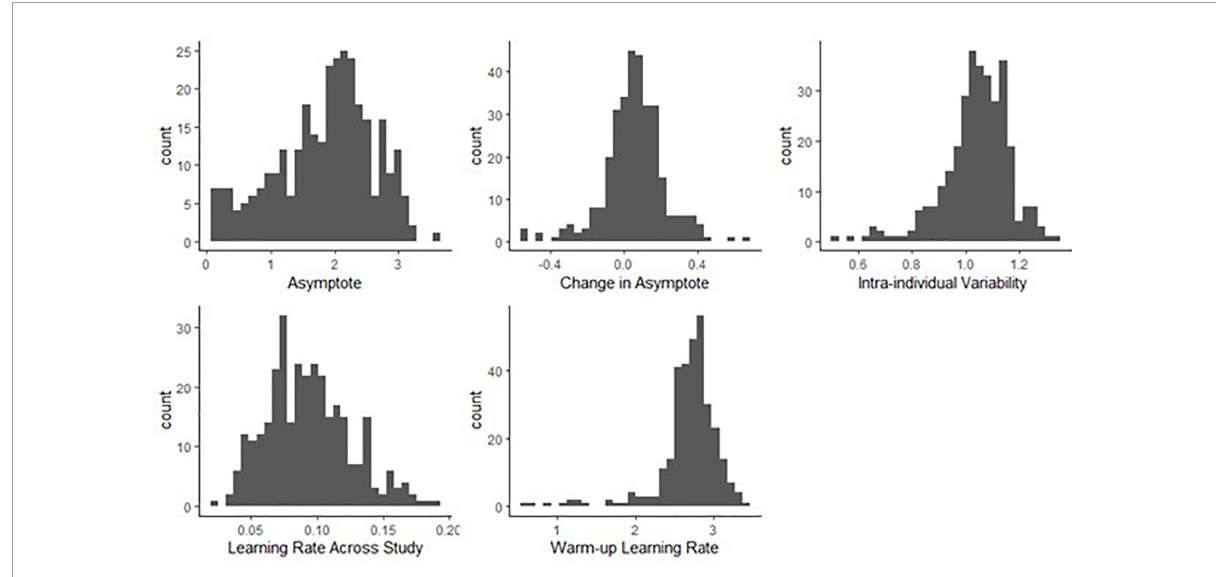
FIGURE9 Histograms of person-specific estimates for key BDEM parameters based on data from the grid memory task. The horizontal axis shows the (binned) parameter values while the vertical axis displays the frequency of occurrence of that value among